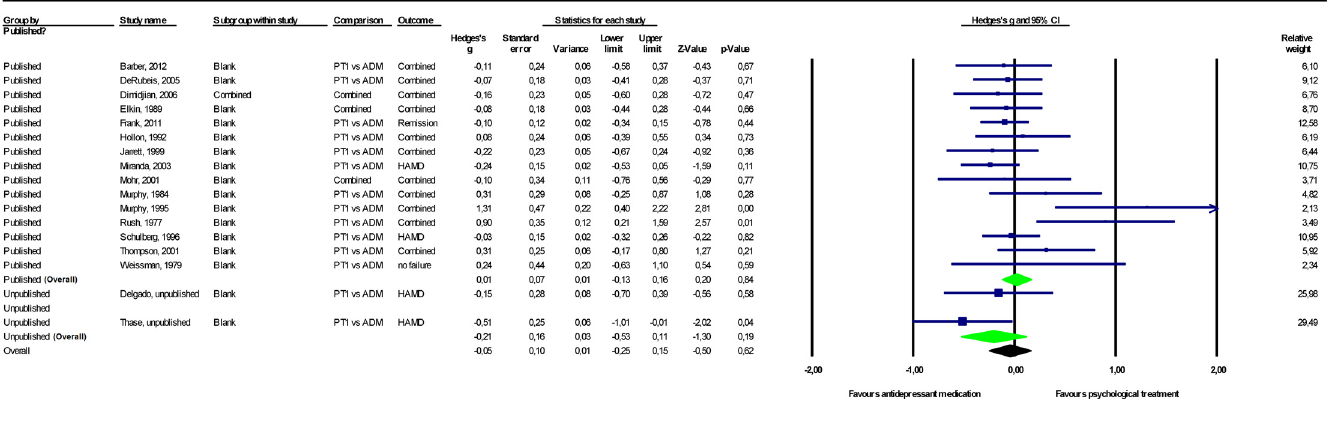
Fig 6. Psychological treatment versus antidepressant medication. Note: Not all results of the unpublished studies are presented at study level, because we did not have permission of the investigators to do so. ADM = antidepressant medication; HAMD = Hamilton Depression Rating Scale; PT = psychological